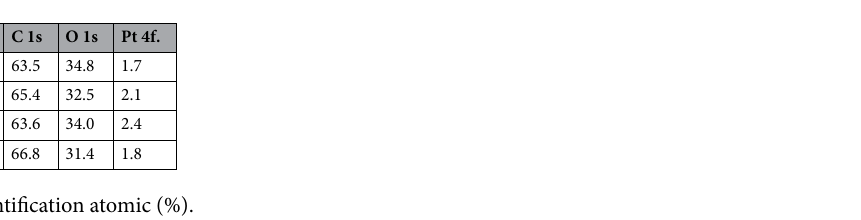
Table 1. Quantification atomic